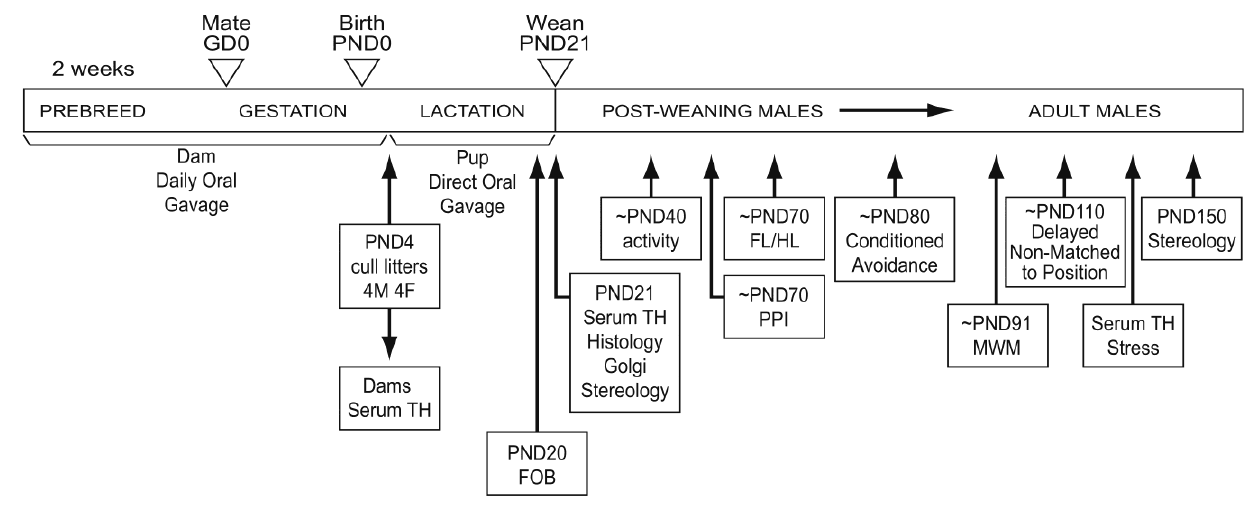
Figure 1. Schematic of dosing and allocation of animals to terminal and behavioral endpoints. Female rats were dosed by oral gavage for 2 weeks prior to breeding and throughout gestation (GD0) until post-partum day 3. The pups were dosed by oral gavage from postnatal day (PND) 4 until PND21. Pups were randomly assigned to groups identified for testing between PND40–80 and then used for PND120 necropsy and a second group was used for behavioral assessments PND90 through to PND150 for unbiased